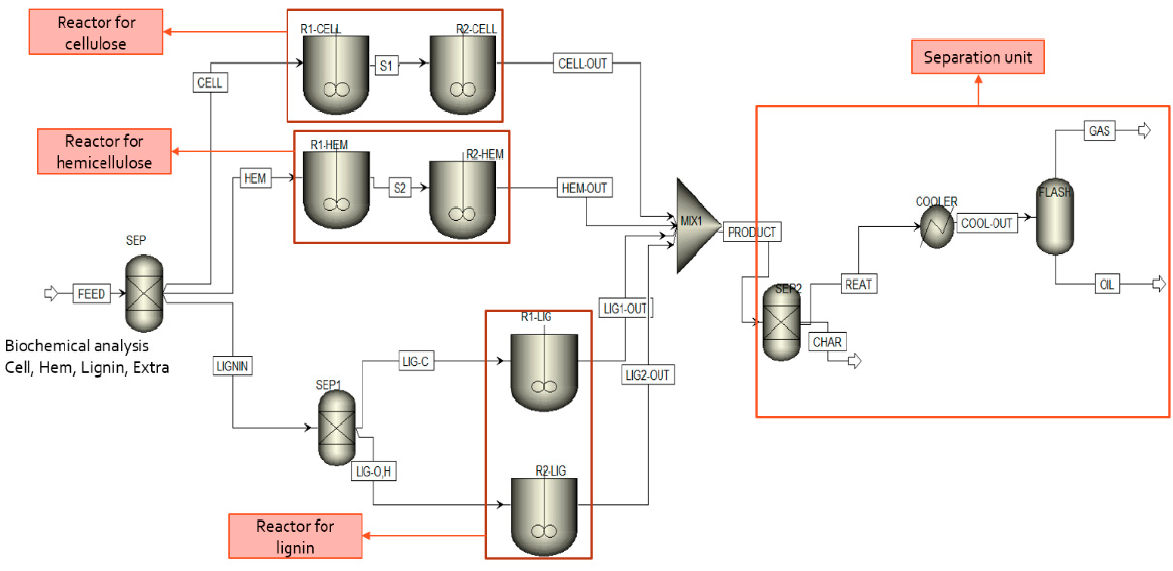
Figure 7. Flowchart of Aspen Plus kinetic simulation of biomass pyrolysis.